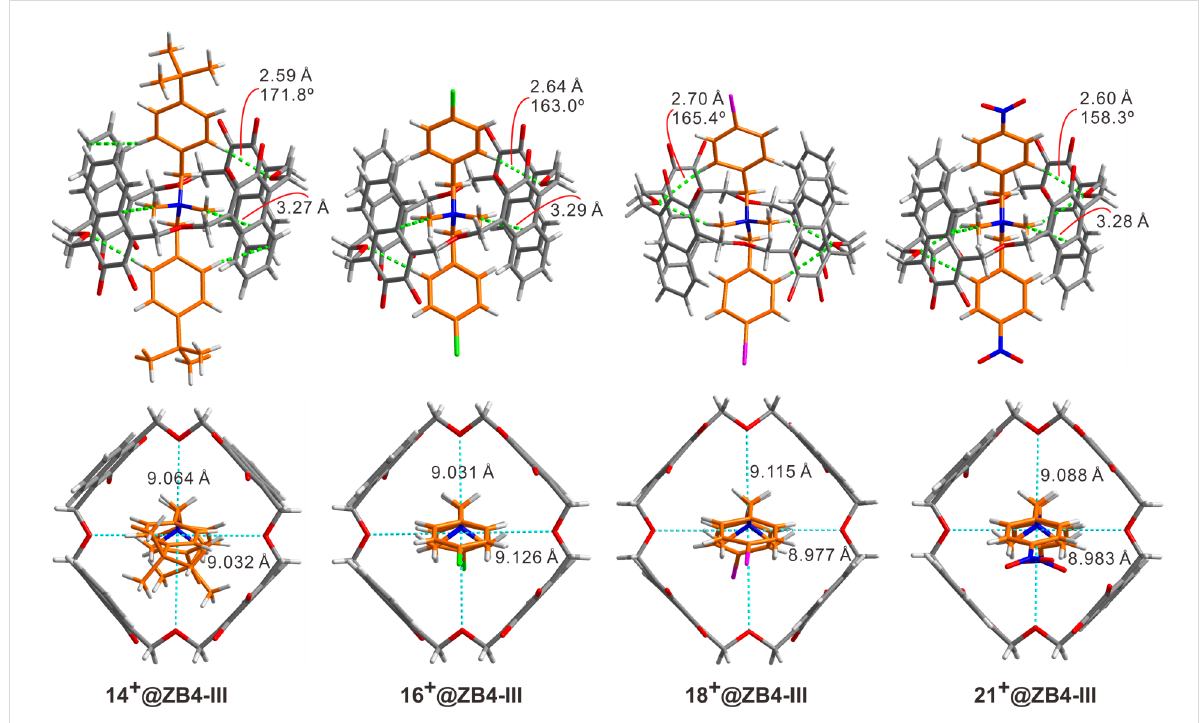
Figure 3: X-ray single crystal structures of 14 + @ ZB4-III , 16 + @ ZB4-III , 18 + @ ZB4-III and 21 + @ ZB4-III . Butyl groups of the host are removed for viewing